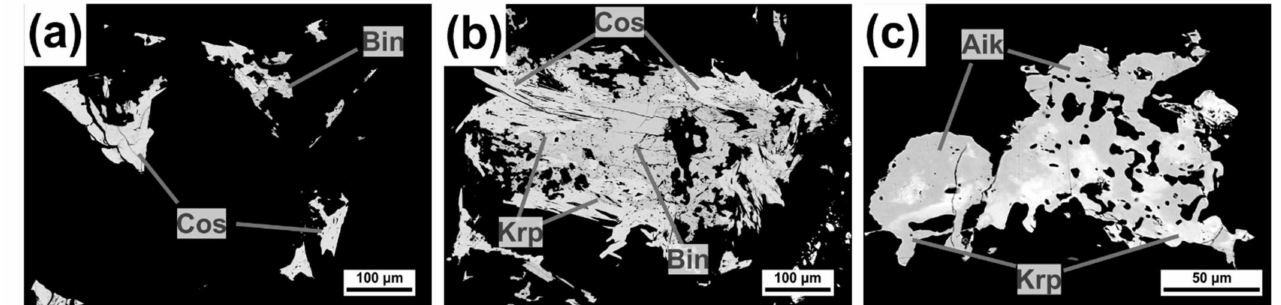
Figure 5. Back-scattered electron (BSE) images showing Bi sulfosalts from the Kizhnica quarry: ( a ) cosalite and bismuthinite crystals; ( b ) aggregate of cosalite and bismuthinite with krupkaite zones between them; ( c ) aikinite–krupkaite aggregate.